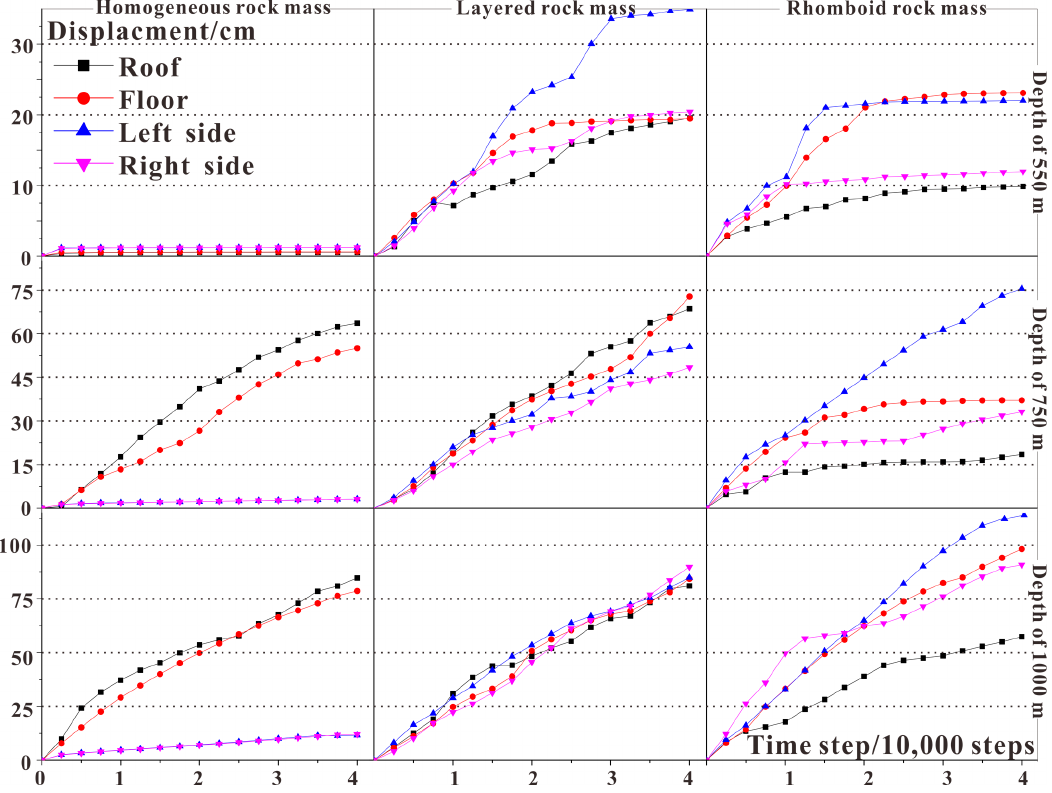
Table 4. Geo-stress applied in PFC.